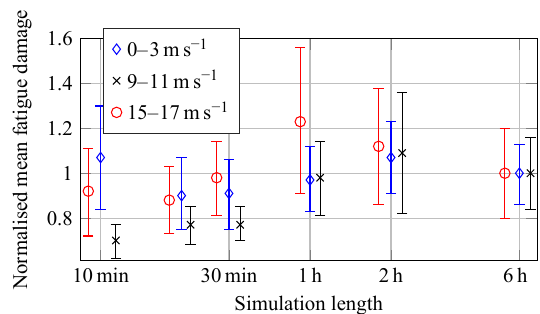
Figure 12. Normalised mean ULS utilisation factor (500 simula- tions) for increasing simulation lengths and different wind